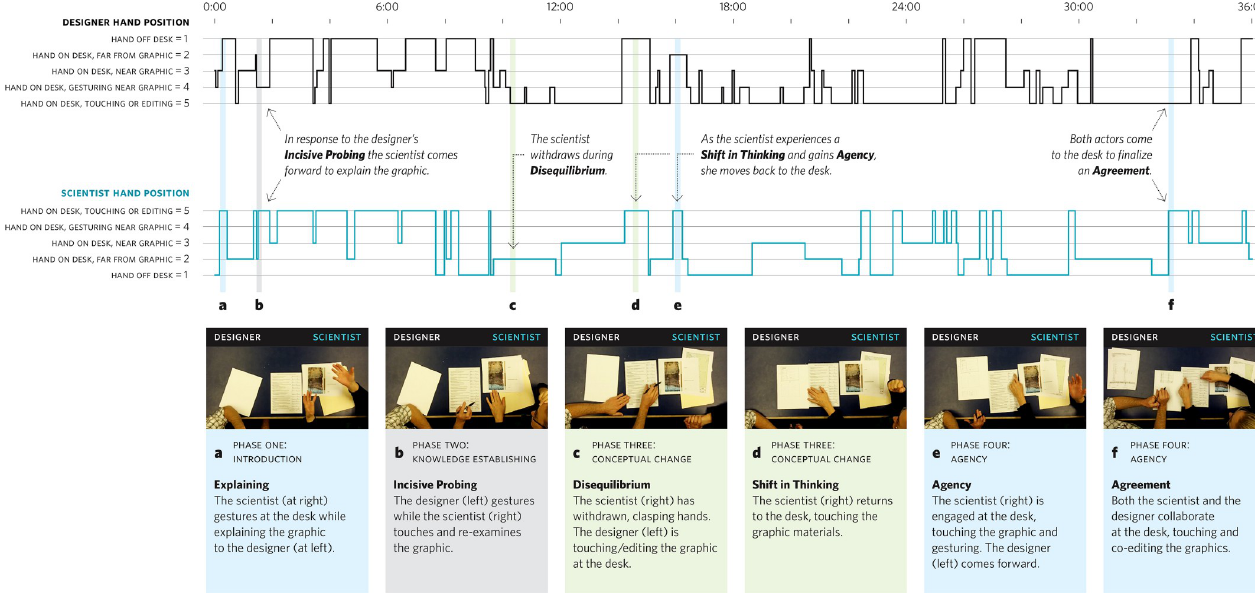
Fig 4. Mapping the interaction between designer and scientist through hand position. We plot the hand position of both the designer (left) and the scientist (right) as captured with an overhead camera at the Design Help Desk. Higher numbers indicate closer proximity to the visual (the graphic). Video stills illustrate the specific phases of a Design Help Desk session as described in Fig